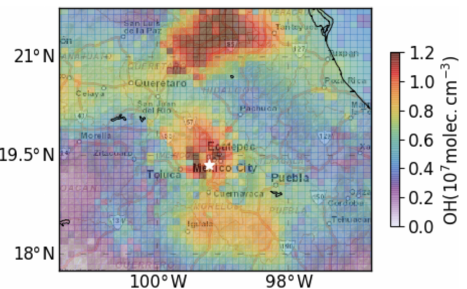
Figure 5. The boundary layer average OH concentration at the TROPOMI overpass time during June to August 2018 over Mex- ico City. The white star represents the centre of Mexico